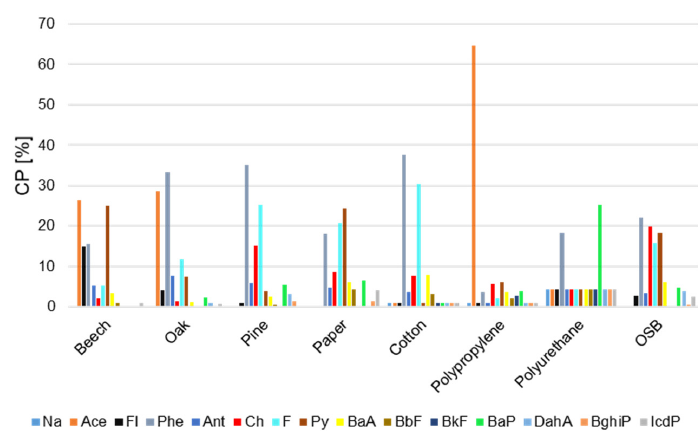
Figure A1. Carcinogenic potential (CP %) of individual compounds from the TSP-bound PAHs during burning of various types of materials.